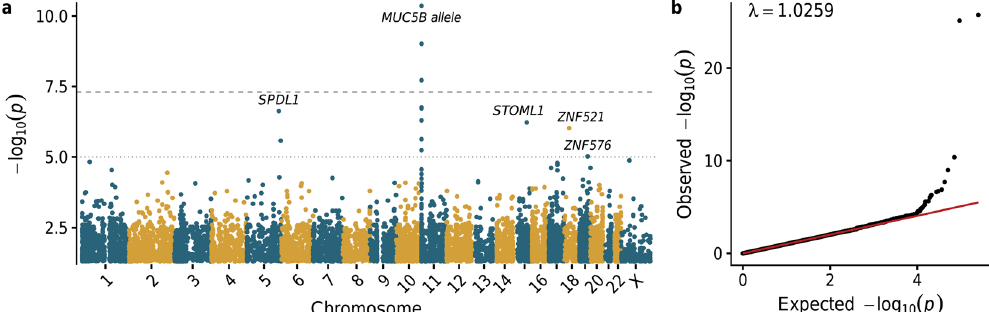
Fig. 2 Association of single-nucleotide variants with IPF. a Manhattan plot depicting p -values of the 564,159 exonic variants tested for association with IPF status in 752 cases and 119,055 controls. The long-dash line indicates the genome-wide signi fi cance threshold ( p < 5 × 10 − 8 ). Relevant to the MUC5B locus, the Y-axis is capped at 1 × 10 − 10 . b Quantile – quantile plot of observed versus expected p -values. Linear regression line is indicated in